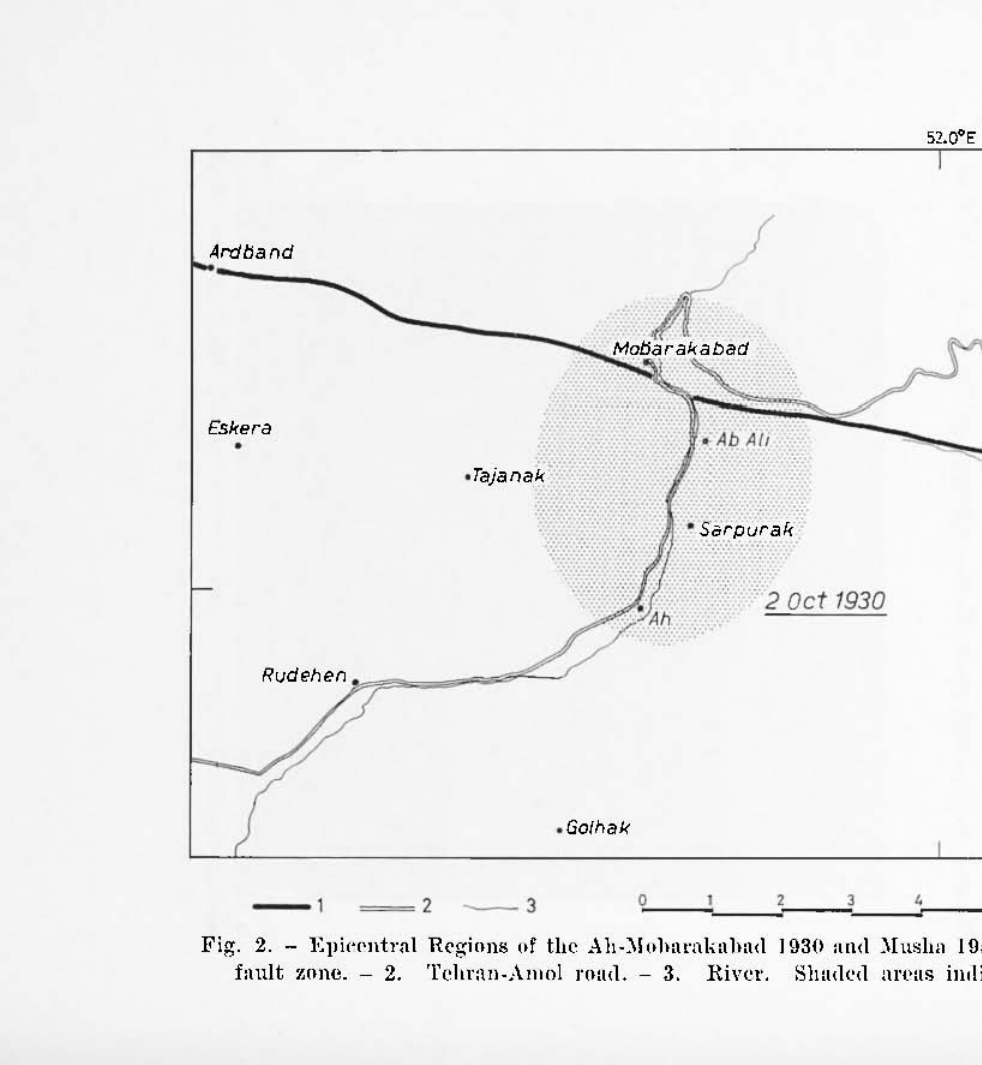
Fig. 2. - EJliePlltral R('gions (Of the Ah·'\I(Ohllrlll'lIhll<1 fault z(lnc. -